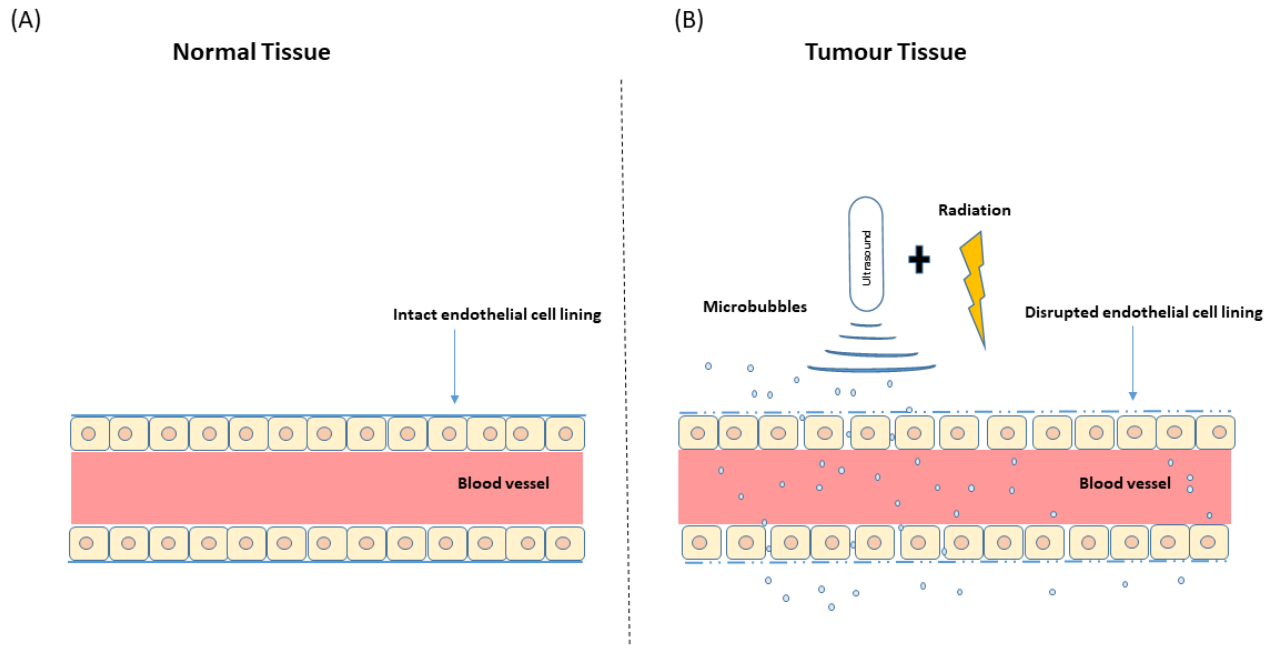
Figure 3. Illustration of normal and tumour vasculature. ( A ) Normal blood vessels are highly orga- nized with regular intact endothelial lining. ( B ) Tumour blood vessels are irregularly shaped with the loosely associated basement membrane. USMB and radiation-induced endothelial membrane perforation result in enhanced vascular permeability inducing greater tumour response. Abbreviations: USMB — ultrasound-stimulated microbubbles.